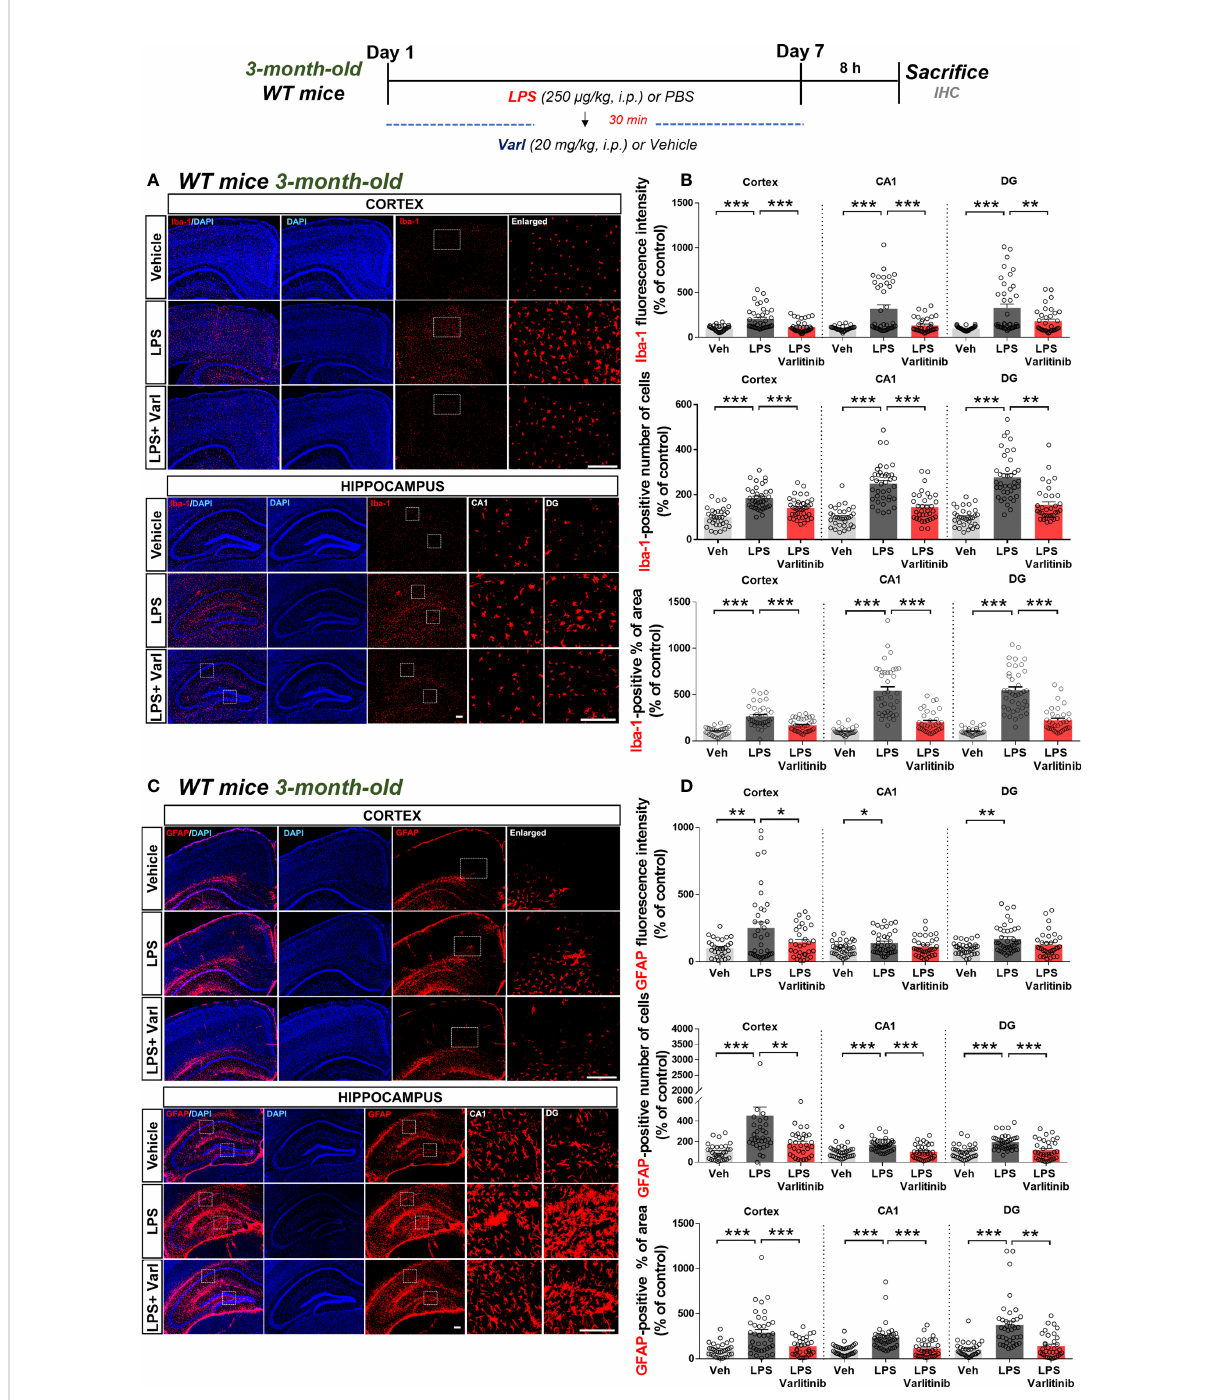
FIGURE 5 Varlitinib reduces LPS-stimulated glial activation in wild-type mice. (A, C) Wild-type mice were injected with LPS (250 m g/kg, i.p.) or PBS and, 30 min later, varlitinib (20 mg/kg, i.p.) or vehicle (5% DMSO, 10% PEG, 20% Tween-80, i.p.) daily for 7 days. On the 7 th day, 8 h after the LPS or PBS injection, immuno fl uorescence staining was performed with anti-Iba-1 and anti-GFAP antibodies. (B, D) Quanti fi cation of data from A and C (n = 8 mice/group, Veh: 32 brain sections; LPS: 38 brain sections; LPS+Varlitinib: 38 brain sections, 2 experimental replicates per group). * p < 0.05, ** p < 0.01, *** p < 0.001. Veh, Vehicle, Scale bar = 50 m